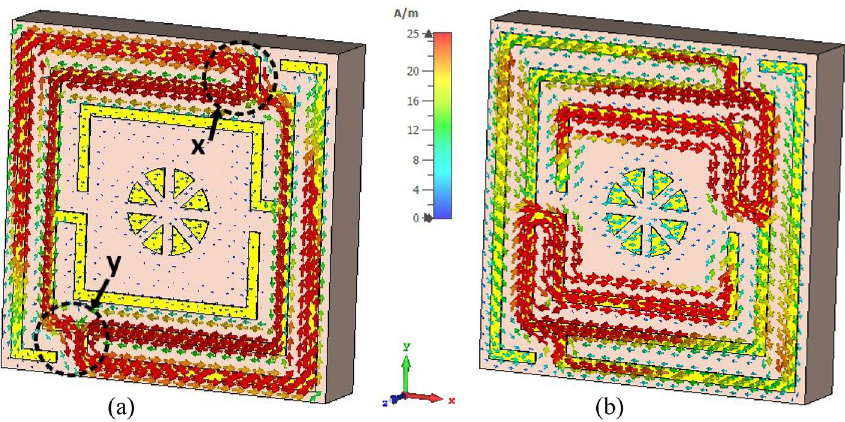
Figure 12. Surface current distribution for the presented MM structure at ( a ) 3.37 GHz and ( b ) 5.8 GHz (CST STUDIO SUITE 2019, https:// www. 3ds. com/ produ cts- servi ces/ simul ia/ produ cts/ cst- studio- suite) 39